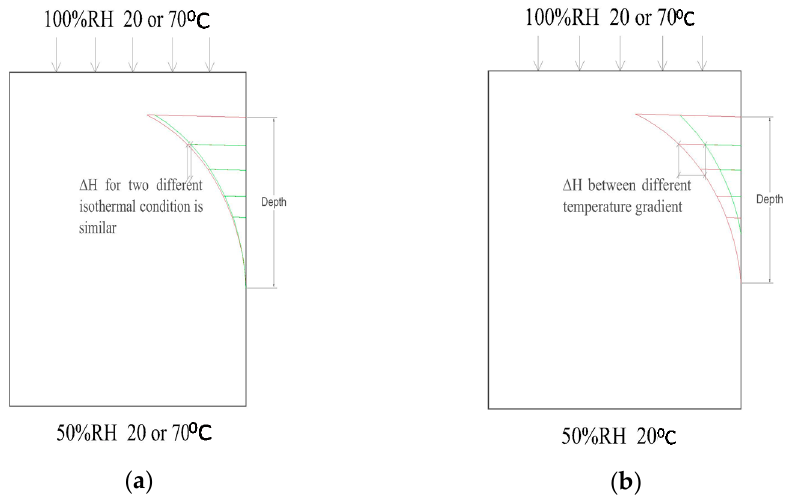
Figure 1. Theoretical model for the study topic: ( a ) isothermal condition test and ( b ) non-isothermal condition test.